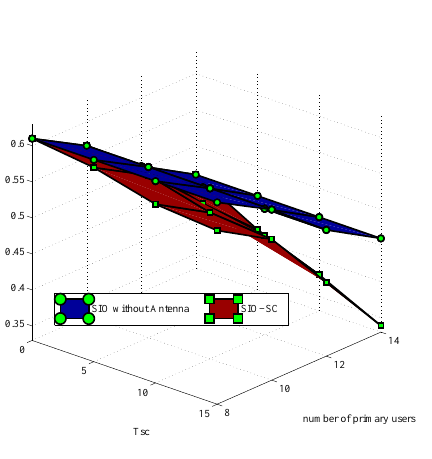
Figure 5. Study the influence of time. Figure 6. Study the influence of T